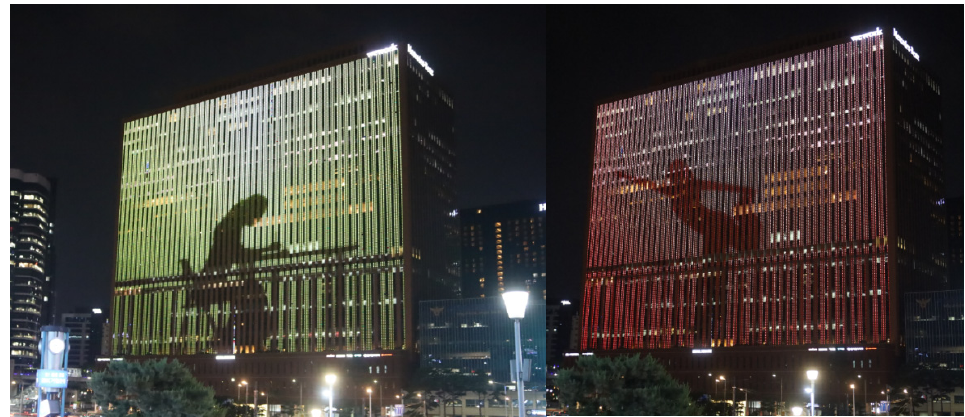
Figure 4. Media Canvas of Seoul Square (20 March 2021). (Sources: Authors). M1, who was in charge of this programme, described it as